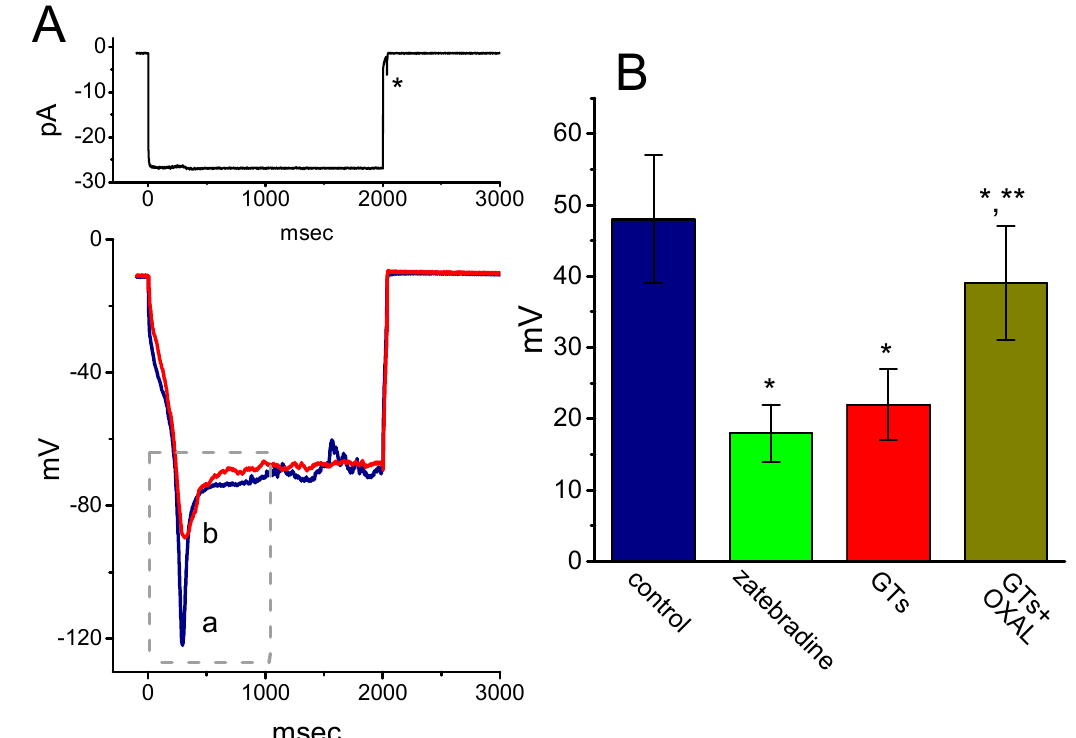
Figure 6. E ff ect of GTs on sag potential recorded under the current-clamp configuration in GH 3 cells. Cells were bathed in normal Tyrode’s solution and we filled the recording pipette with K + -containing solution. As the whole-cell recordings were established, the experiment was swiftly switched to current-clamp condition with 2-sec hyperpolarizing current stimuli. ( A ) Potential traces obtained in the absence (a) and presence (b) of 10 µ g / mL GTs. Dashed box indicates the sag potential in response to long-lasting hyperpolarizing current (as indicated in the upper part), and the asterisk is the action current taken as membrane potential return to the resting potential. ( B ) Summary bar graph showing the e ff ects of zatebradine (10 µ M), GTs (10 µ g / mL) and GTs (10 µ g / mL) plus oxaliplatin (OXAL, 10 µ M) on the amplitude of sag potential in GH 3 cells (mean ± SEM; n = 7 for each bar). *Significantly di ff erent from control ( p < 0.05) and **significantly di ff erent from GTs alone group ( p < 0.05).